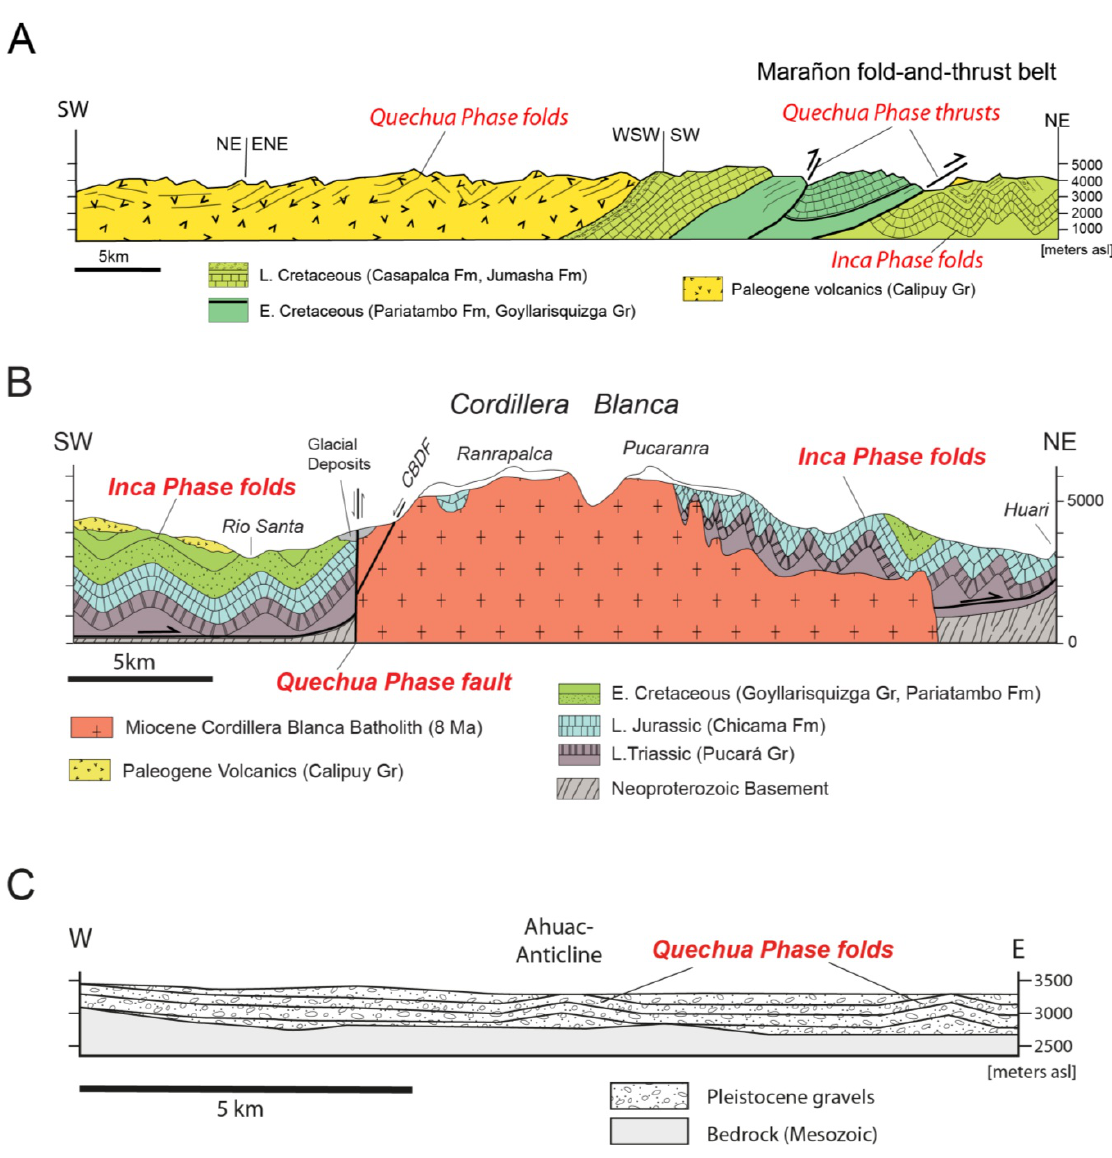
Figure 19. Deformation features linked to the Quechua Phase in the Western Cordillera and the Central Highlands (see Figure 7 for location). ( A ) Cross-section Canta–Abra La Viuda showing Quechua Phase thrusts uplifting the Western Cordillera. RVQ: Raura–La Viuda–San Jose de Quero thrust; ( B ) Cross-section of the Cordillera Blanca east of Huaraz showing uplift of the Cordillera Blanca Batholith relative to the folded Mesozoic units to the SW. CBDF: Cordillera Blanca detachment fault; ( C ) Cross-section of folded Pleistocene gravels in the Central Highlands west of